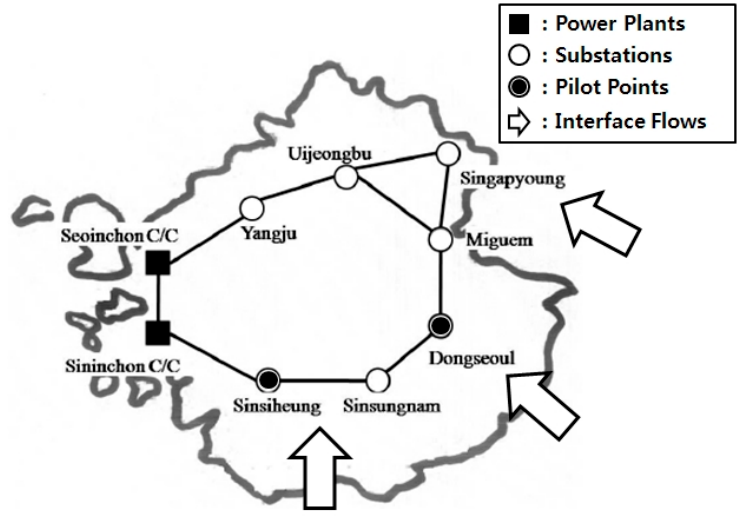
Figure 10. Map of the metropolitan area in the Korean power system.